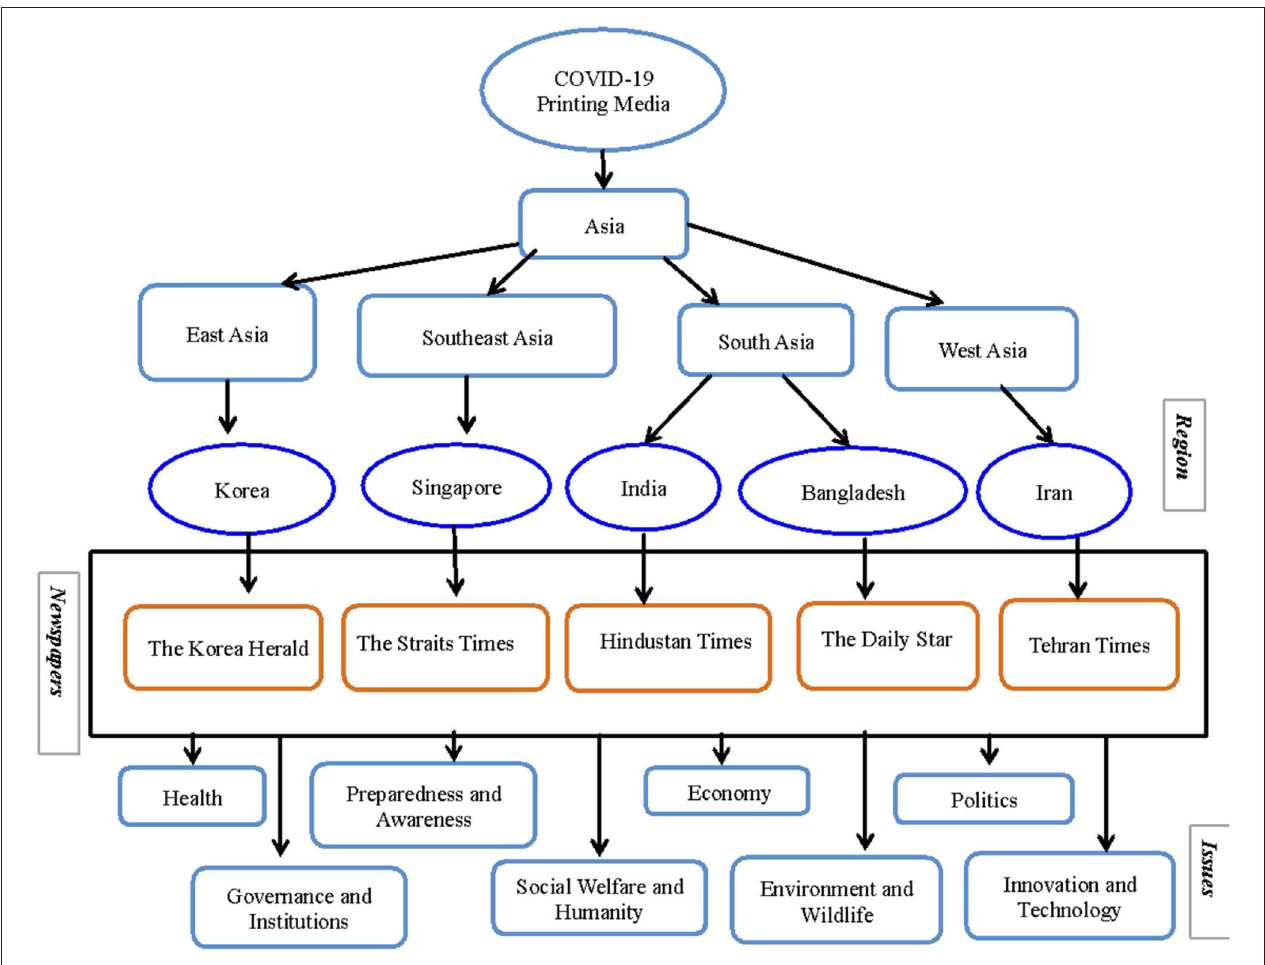
FIGURE 2 | Regions, newspapers, and issues addressed in this study.